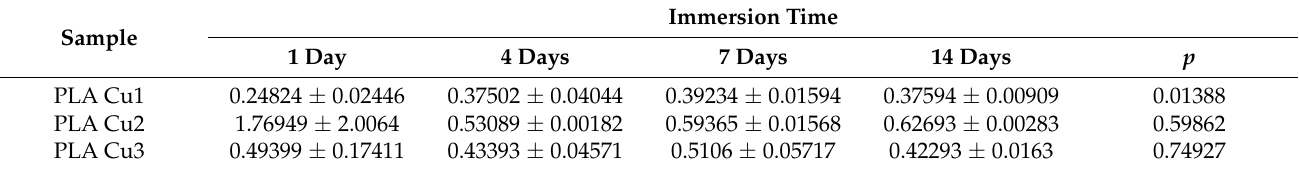
Table 7. Absorption values and ± standard deviation according to the immersion time of the